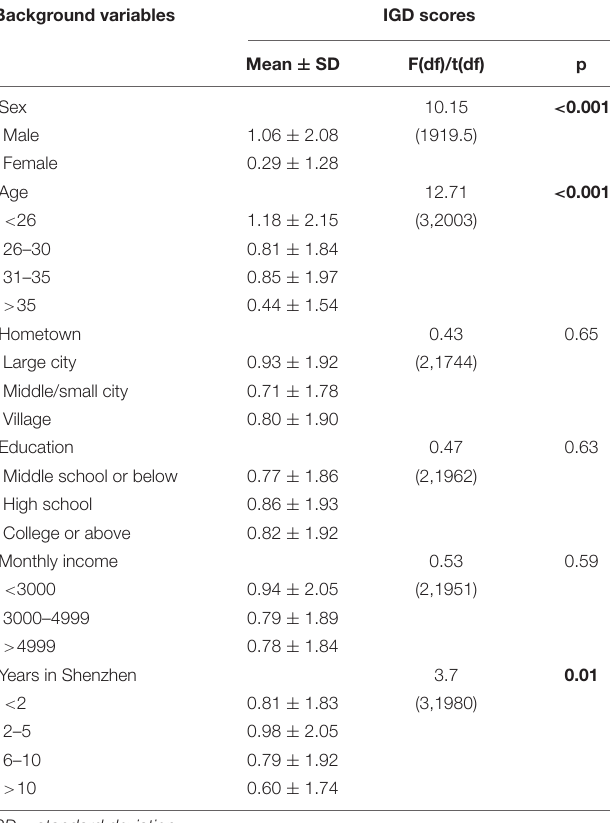
TABLE 2 | Internet gaming disorder (IGD) scores by background status.